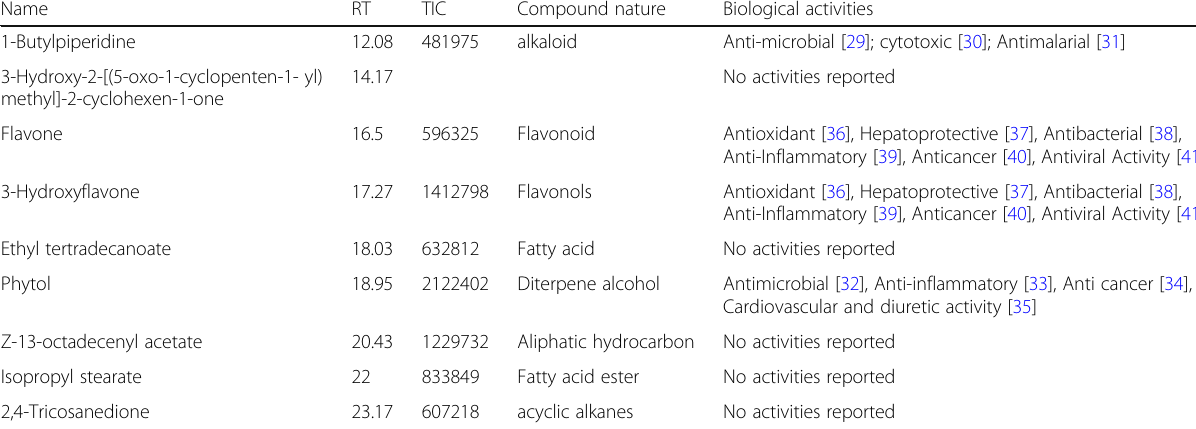
Table 2 Phytochemicals present in the methanolic extract of an in vitro grown L. cruciata and their biological activities